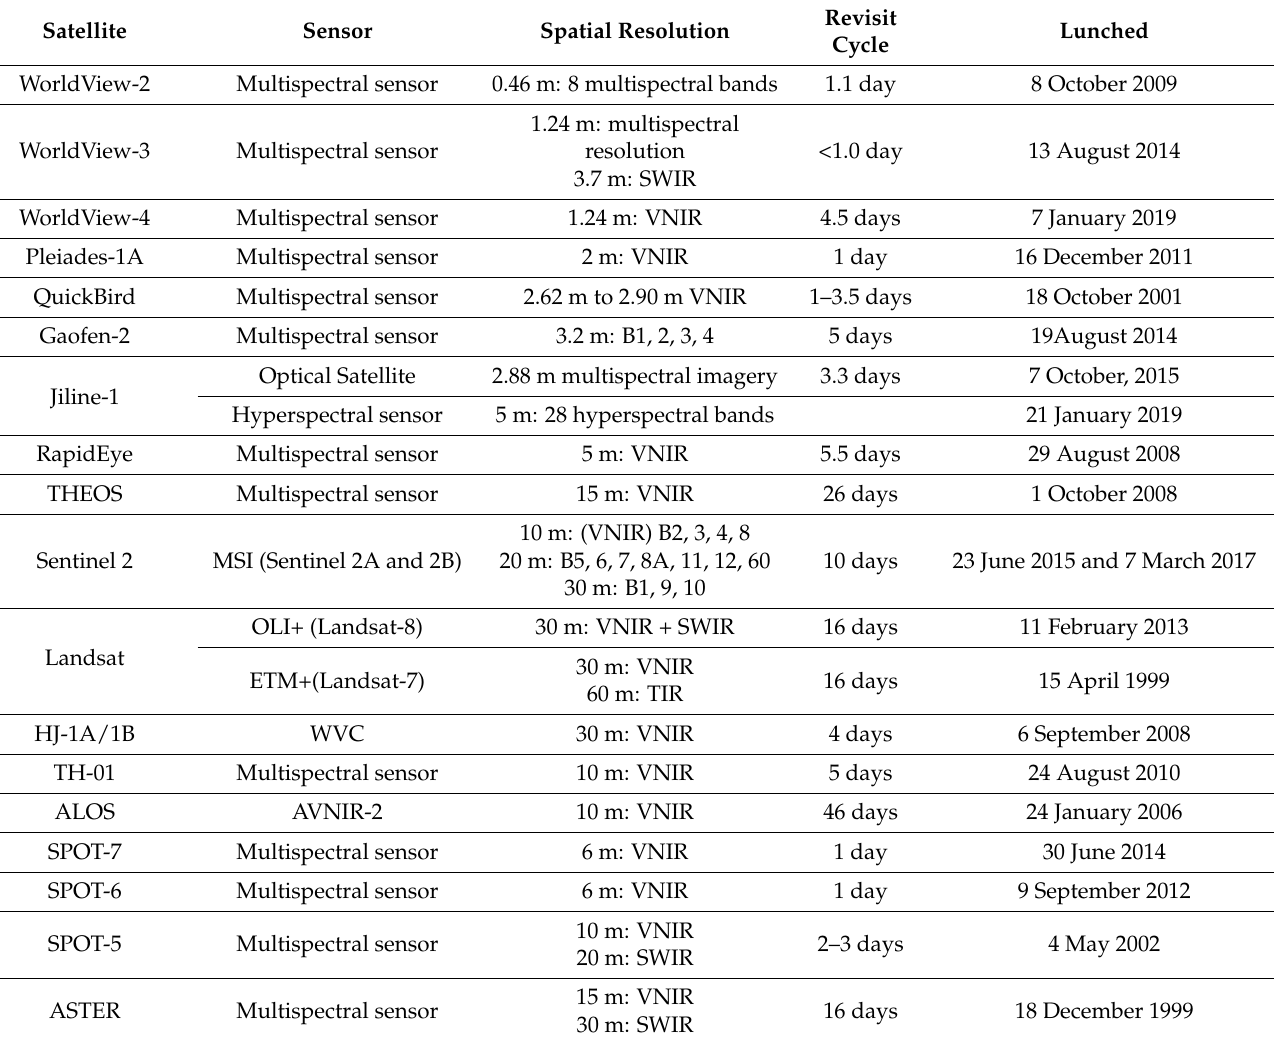
Table 3. Satellite sensors collecting multispectral images with spatial resolution (0.5–30 m) and spatial